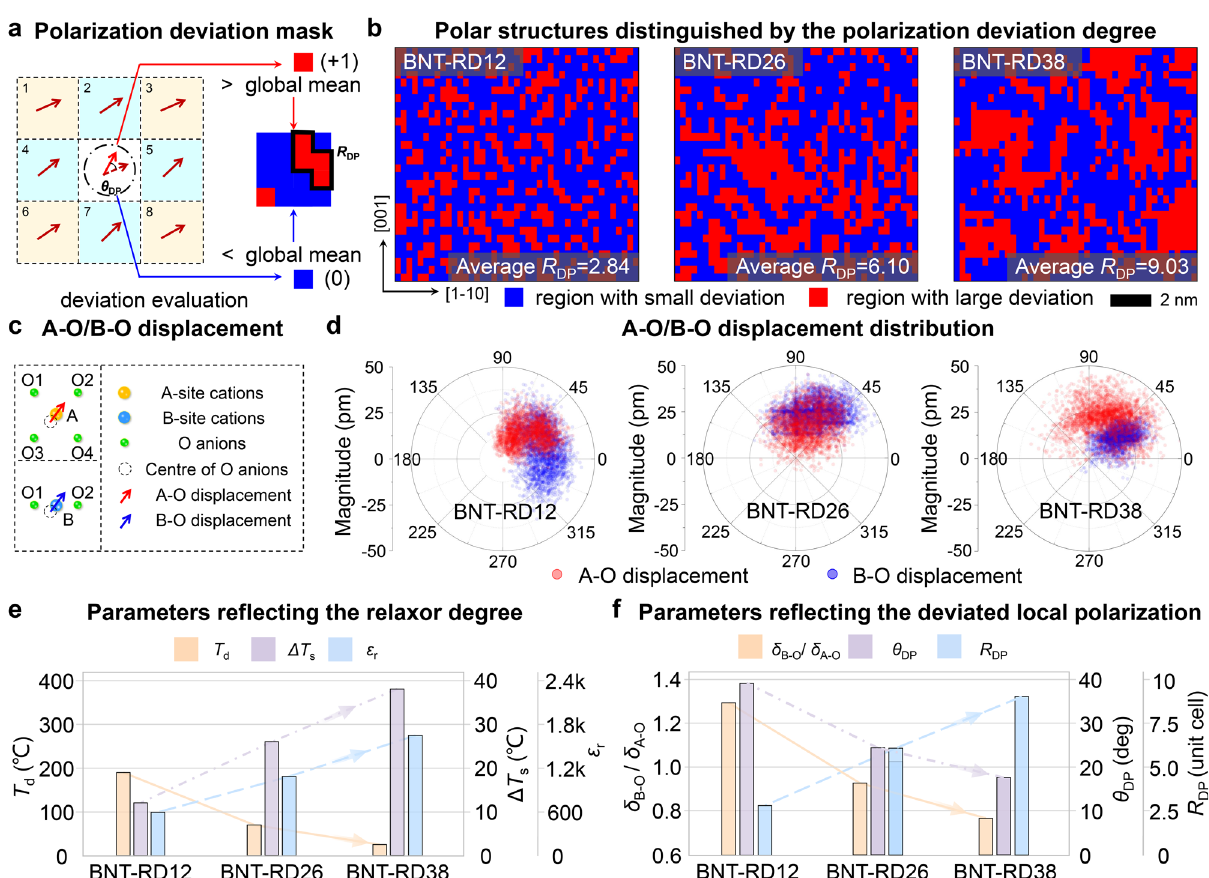
Fig. 2 | Structural mapping on ionic displacement and polarization variation. a Schematicillustrationofthemethodappliedtoevaluatethedeviationdegreeof polarizations. b The[110] p projectedlocalstructurere fl ectingdifferent deviation degrees of polarization angles in the BNT-based system, according to the eva- luation principle in ( a ). c Schematic illustration of A – O/B – O displacement cal- culated by the relative offset of the A/B-site cations from the center of four/two